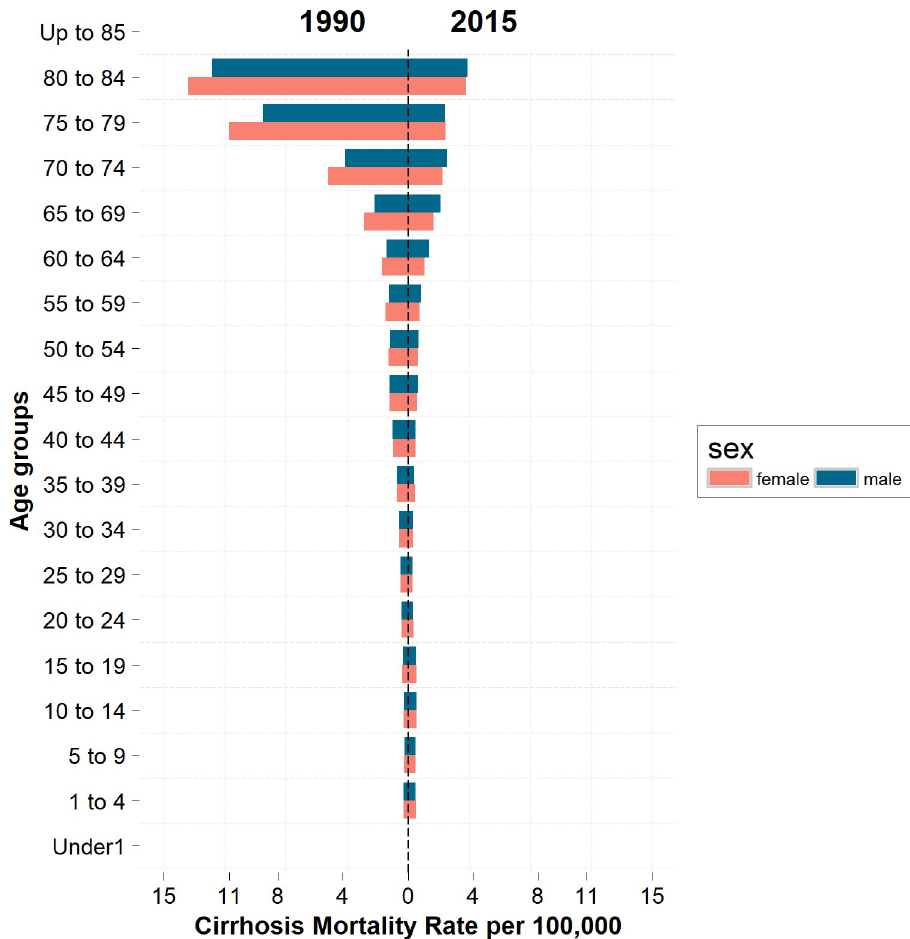
Fig 4. Age adjusted mortality rate in females and males by age in Iran between 1990 and